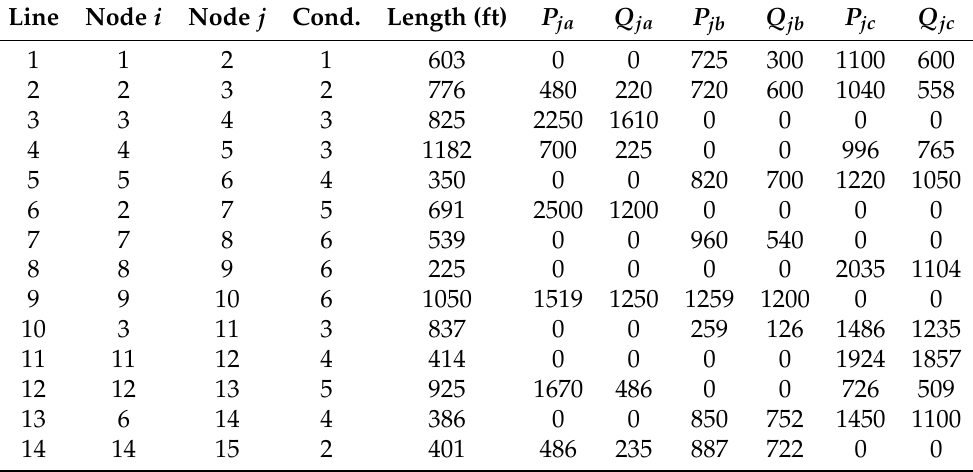
Table 2. Load and line parameters of the 15-bus test system (all power values are in kW and kvar).